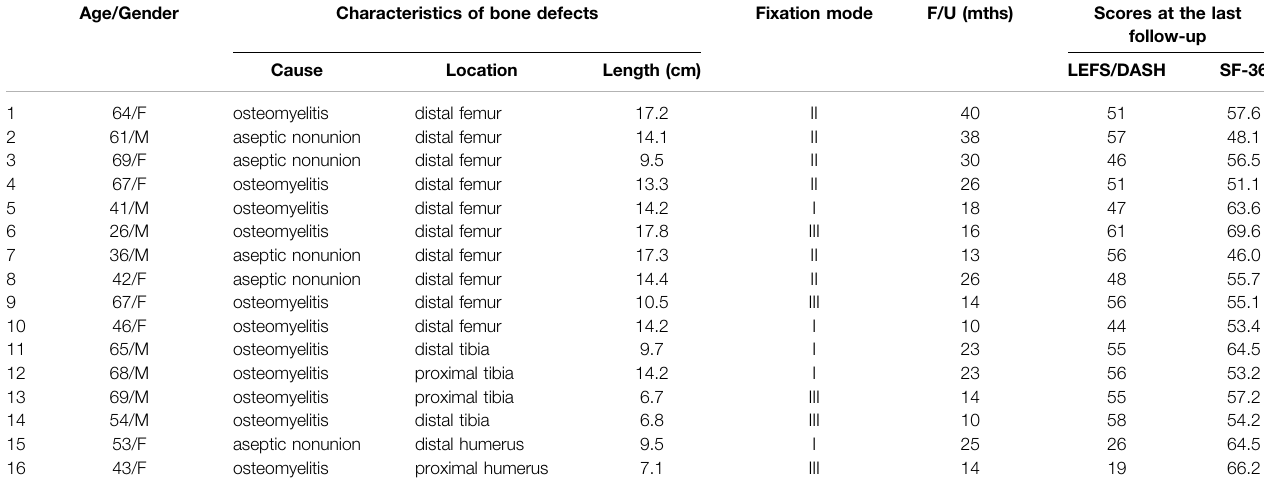
TABLE 1 | The clinical information of the enrolled patients.